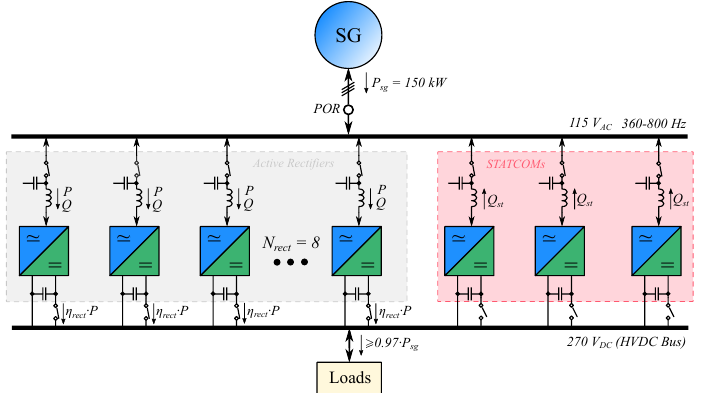
Figure 14. Simplified schema of the proposed active modular 2L st architecture